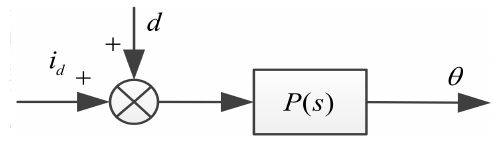
Figure 3. Block diagram of Equation (14).